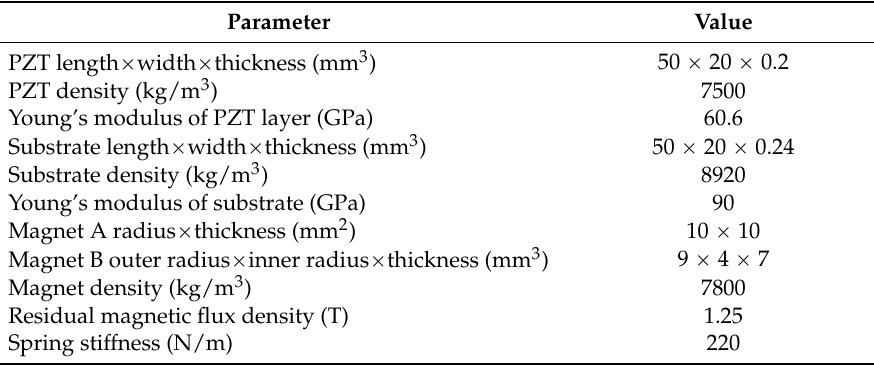
Table 1. Geometric and physical properties of the hybrid energy harvester (HEH).